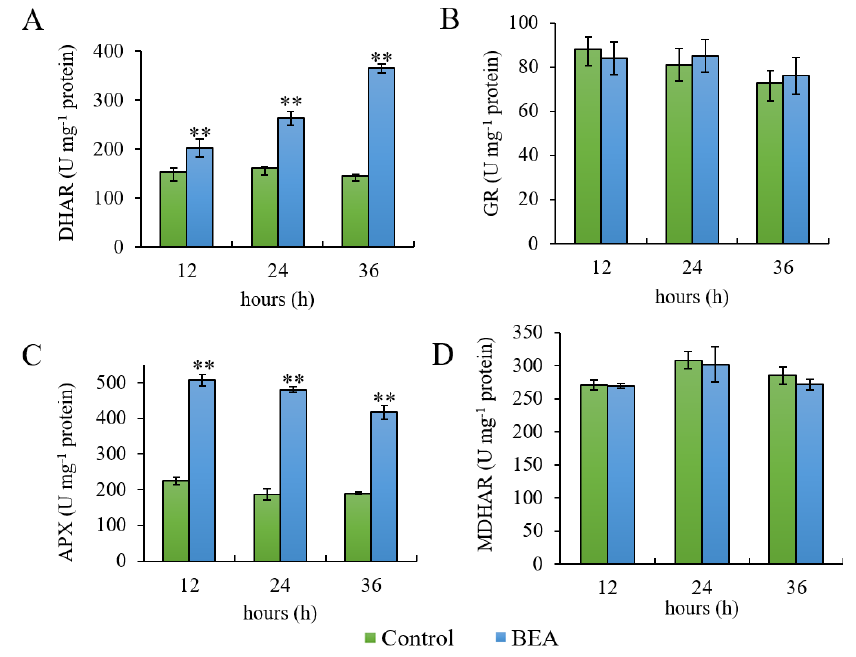
Figure 3. Enzyme activity of dehydroascorbate reductase — DHAR ( A ), glutathione reductase — GR ( B ), ascorbate peroxidase — APX ( C ) and monodehydroascorbate reductase — MDHAR ( D ) in control and beauvericin (BEA) treated samples during 36 h of assay. One unit (U) corresponds to 1 nmol of the substrate metabolized in 1 min. Asterisks indicate values significantly different from the control at each time point, according to the Student’s t test with p < 0.01 (**).